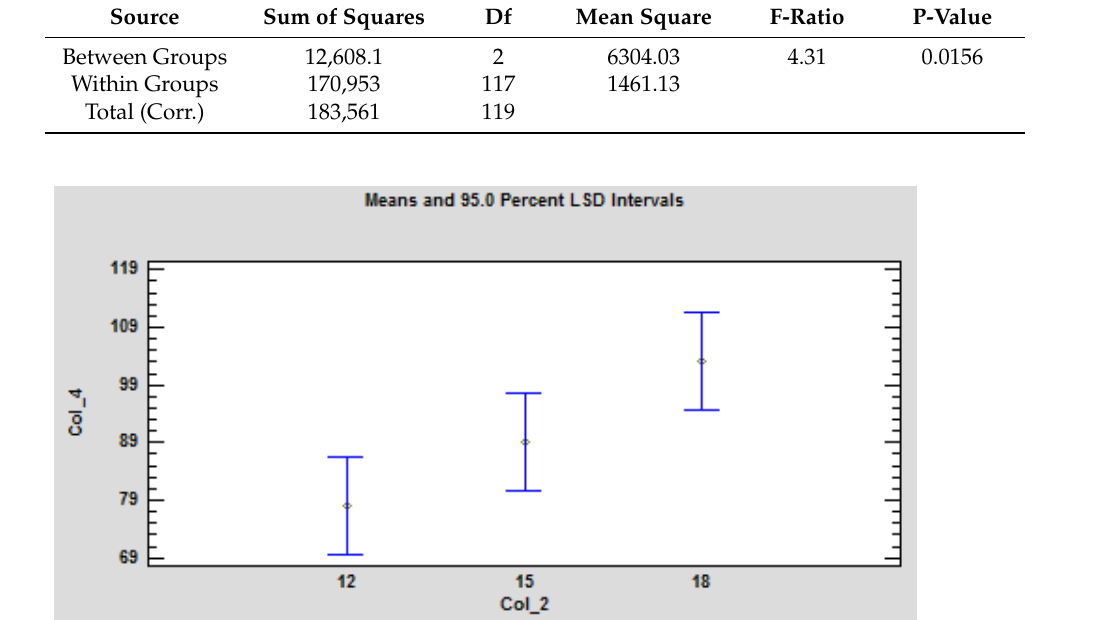
Table 4. ANOVA table for Col_4 Time-to-ignition by Col_1 heat flux.